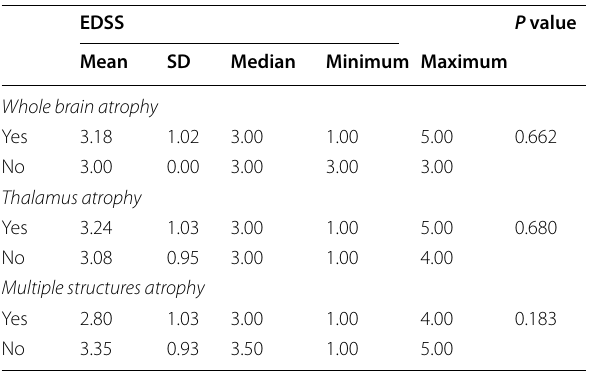
Table 10 Relation between EDSS and whole brain, thalamic, multiple structure atrophy EDSS